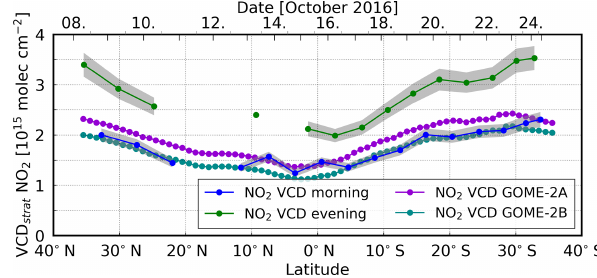
Figure 8. The latitudinal dependency (from north to south) of stratospheric NO 2 over the Atlantic Ocean shows a local minimum near the Equator and an increase towards the midlatitudes. MAX- DOAS morning and evening values have been averaged over all zenith sky measurements for SZAs between 88 and 92 ◦ . The colour- shaded areas indicate the errors of the